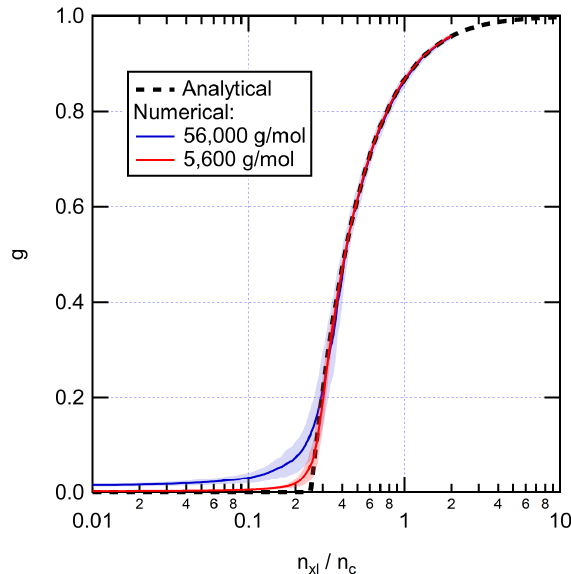
Figure 3. Evolution of the gel fraction as a function of the number of cross-links per chain for initially linear PE systems. Numerical results are averaged over 100 runs. Shading represents standard deviation.